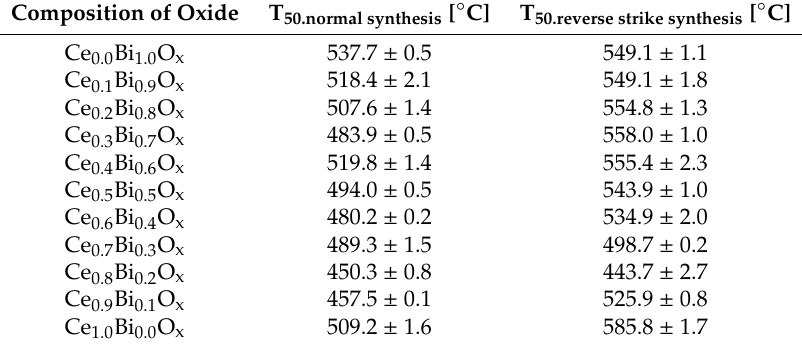
Table 5. T 50 values for Diesel soot oxidation in tight contact mode of the synthesized mixed oxides determined by TGA. Measurement temperature in the range of T = 25–700 ◦ C with heating rate of r = 5 ◦ C · min − 1 in synthetic air. The averages of double determination with standard deviations are